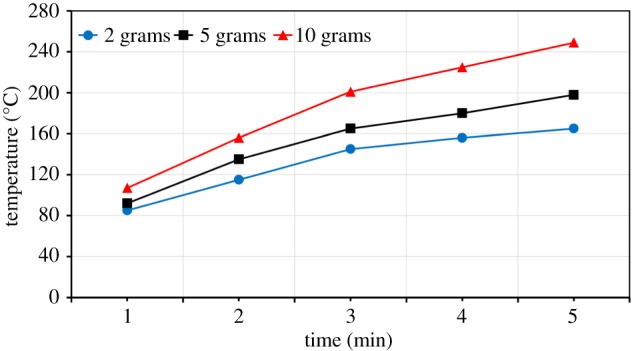
Effect of the sample mass on the temperature of ZnFe2O4.